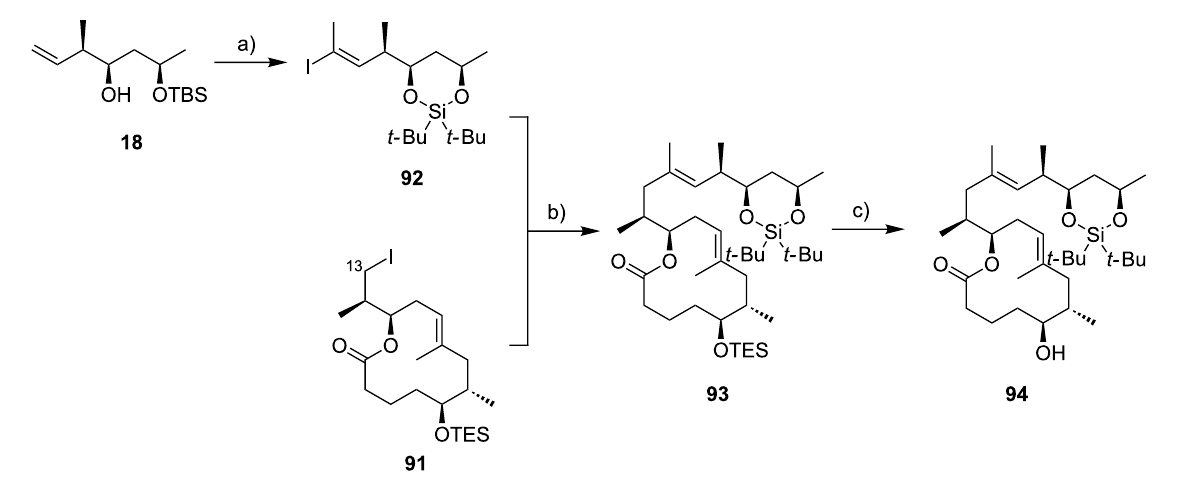
Scheme 8: Final steps of Altmann’s synthesis of the extended core structure of mycolactones. Reagents and conditions: a) (i) TBAF, THF, rt, 83%; (ii) t- Bu 2 Si(OTf) 2 , pyridine, CH 2 Cl 2 , 0 °C, 87%; (iii) O 3 , CH 2 Cl 2 , − 78 °C, then Me 2 S, PPh 3 , − 78 °C to rt, 84%; (iv) CBr 4 , PPh 3 , CH 2 Cl 2 , 0 °C, 88%; (v) n- BuLi, MeI, THF, − 78 °C, 79%; (vi) Cp 2 Zr(H)Cl, THF, 45 °C, then I 2 , 0 °C, 95% (Gehringer, Bucher & Altmann, unpublished); b) 91 , 9-MeO-9- BBN, t- BuLi, Et 2 O, THF, − 78 °C to rt, then 92 , [Pd(dppf)Cl 2 ], AsPh 3 , Cs 2 CO 3 , DMF, rt, 80% (optimized: 97%; Gehringer & Altmann,